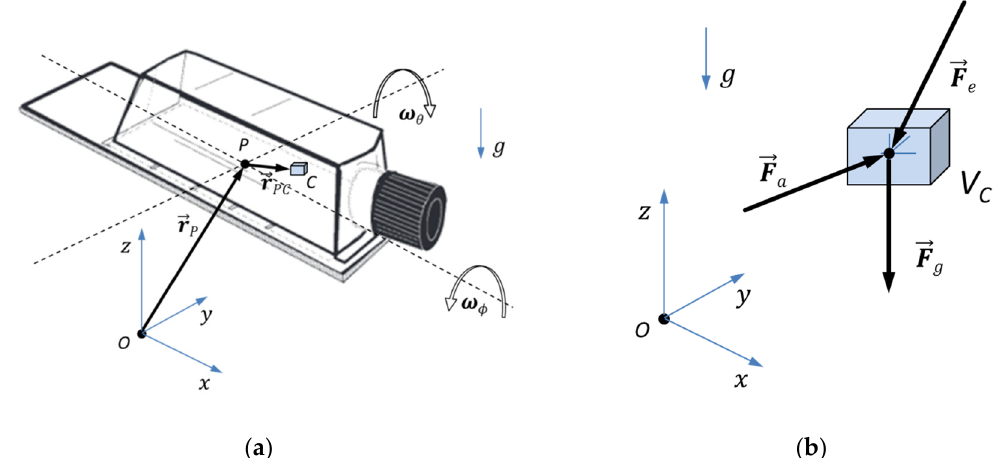
Figure 2. ( a ) Position vectors r in a typical rotating set-up with angular velocities ω ; ( b ) Forces acting on a single cell.